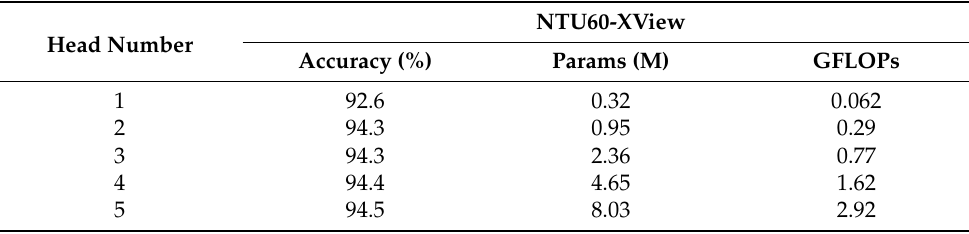
Table 3. Differences in accuracy, number of parameters, and computational complexity according to the number of attention heads in the NTU60-XView